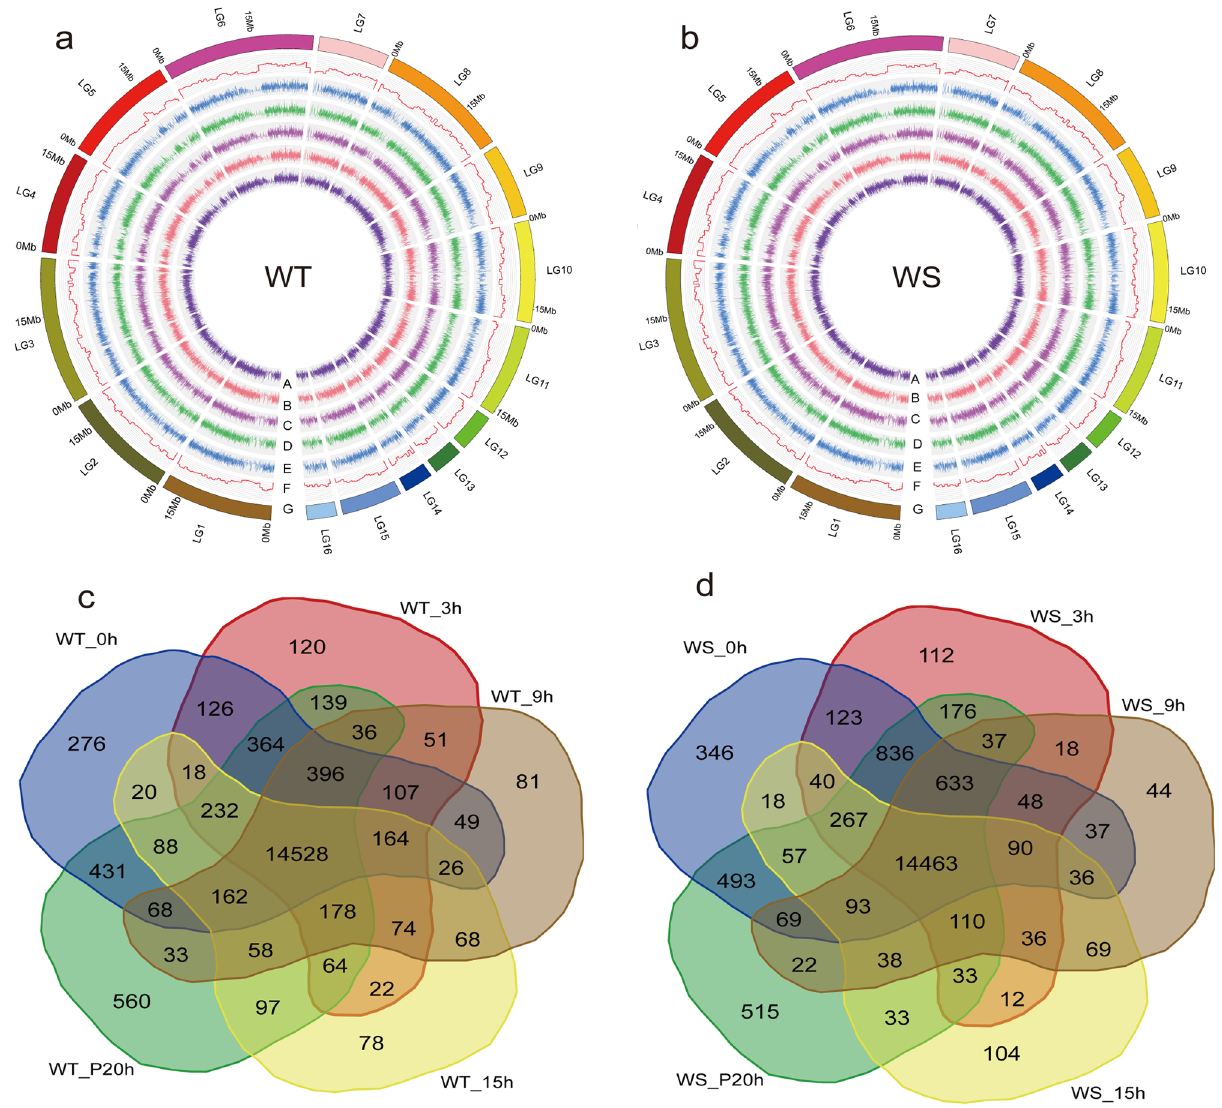
Fig 1. An overview of gene expression in WT and WS plants. (a) and (b) indicate the gene expression levels (RPKM (cid:3) 1, RPKM: reads per kilobase of transcript per million mapped reads) in WT and WS plants at each time point, respectively. (A), (B), (C), (D), and (E) correspond to the samples at 0, 3, 9, and 15 h during waterlogging and 20 h post drainage, respectively. (F) represents the gene density (mRNA, 500-kb window) in the sesame linkage groups, and (G) represents the 16 assembled pseudomolecules of sesame. (c) and (d) indicate the shared and uniquely expressed gene numbers during a time-point assay of waterlogging. WT: waterlogging-tolerant sesame genotype, WS: waterlogging-susceptible sesame genotype.